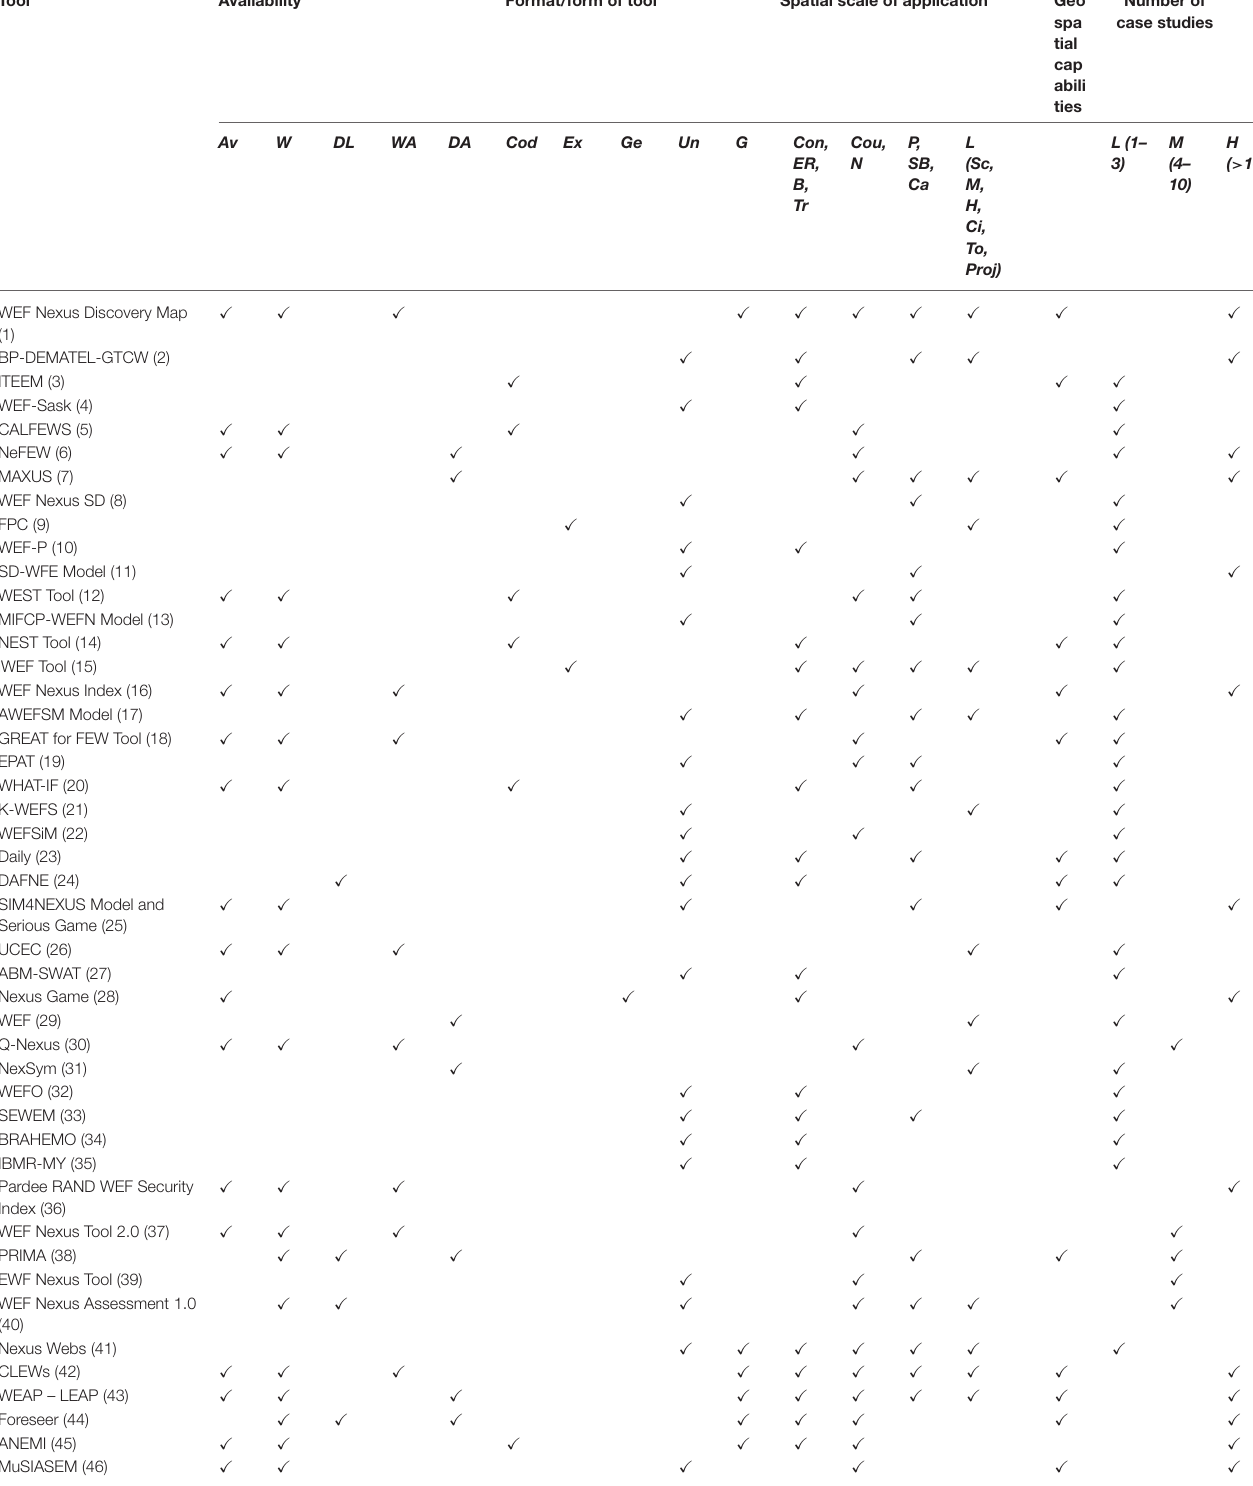
TABLE 5 | Characteristics of existing 46 WEF nexus